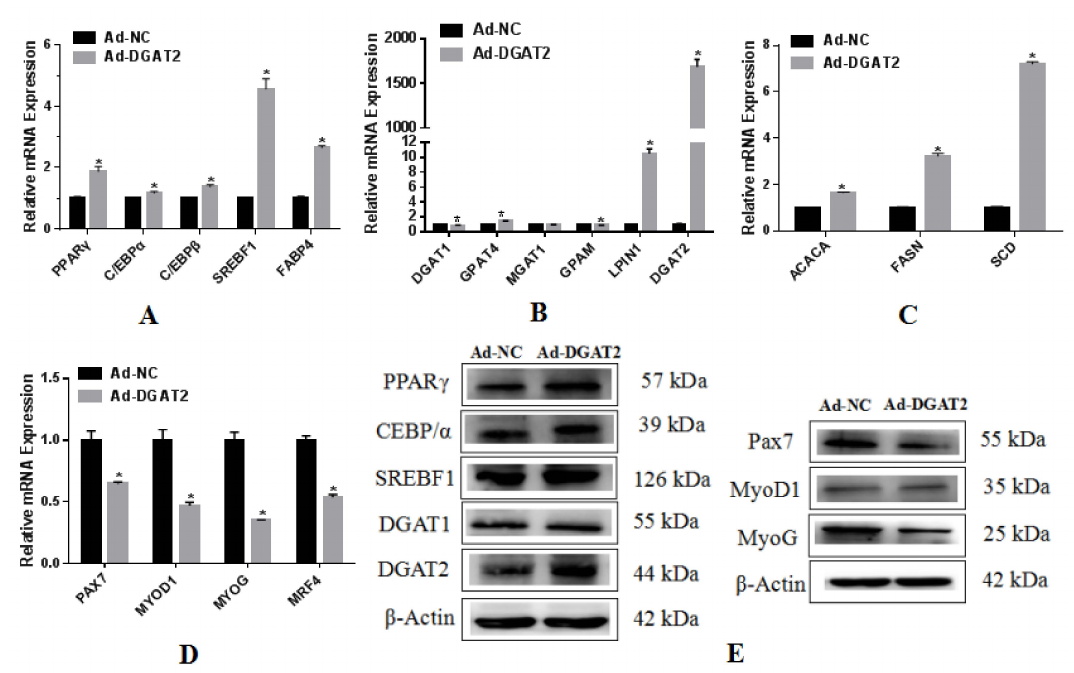
Figure 5. Overexpression of DGAT2 upregulates the expression of genes related to adipogenesis and lipid metabolism in BSCs. The mRNA expression levels of genes associated with ( A ) adipogenesis, ( B ) triacylglycerol synthesis, and ( C ) fatty acid synthesis in BSCs. Values are presented as means ± SEM from three individual cultures. * p < 0.05. ( D ) Overexpression of DGAT2 downregulates myogenesis- related gene expression in BSC. ( E ) Protein levels of adipogenesis markers PPAR γ , SREBF1, C/EBP α , DGAT2, and DGAT1 and myogenesis markers Pax7, MyoD1, and MyoG.